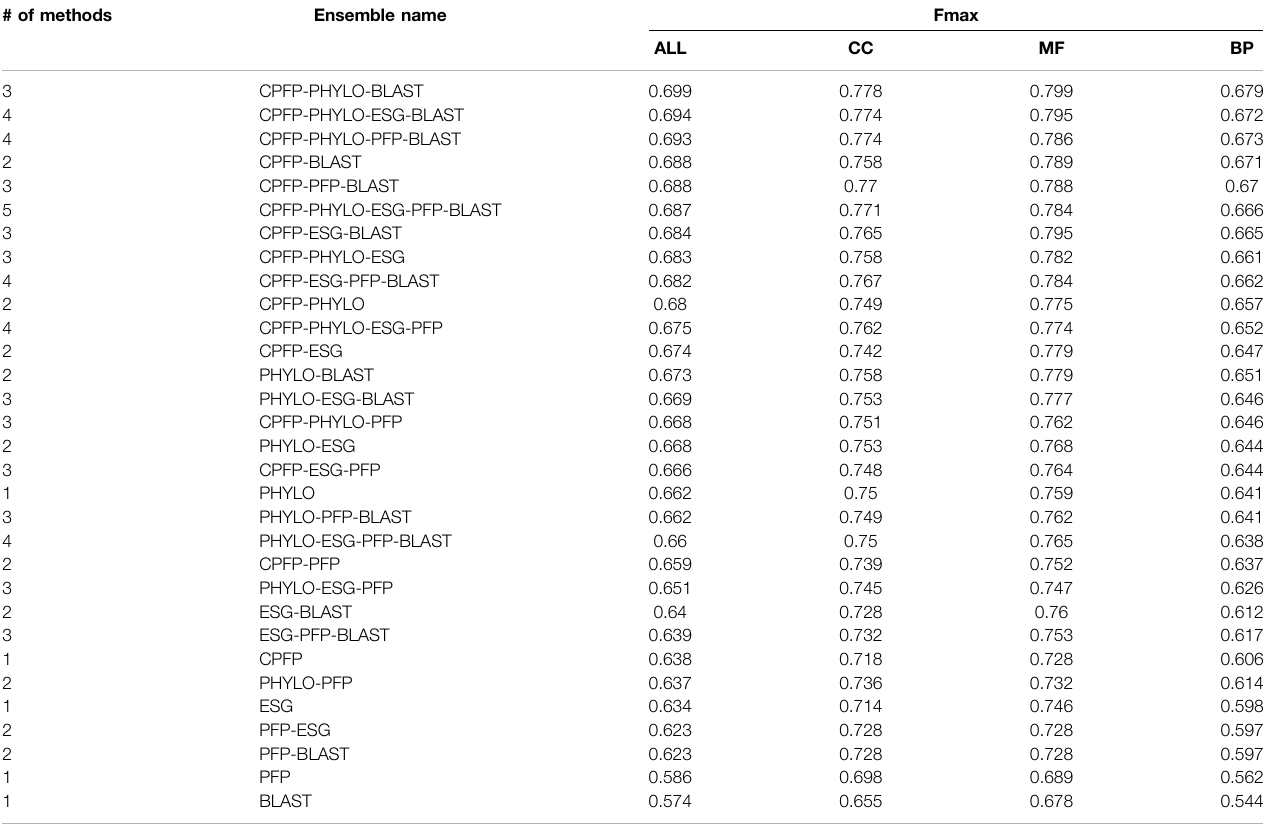
TABLE 6 | The function prediction performance of ensemble methods.